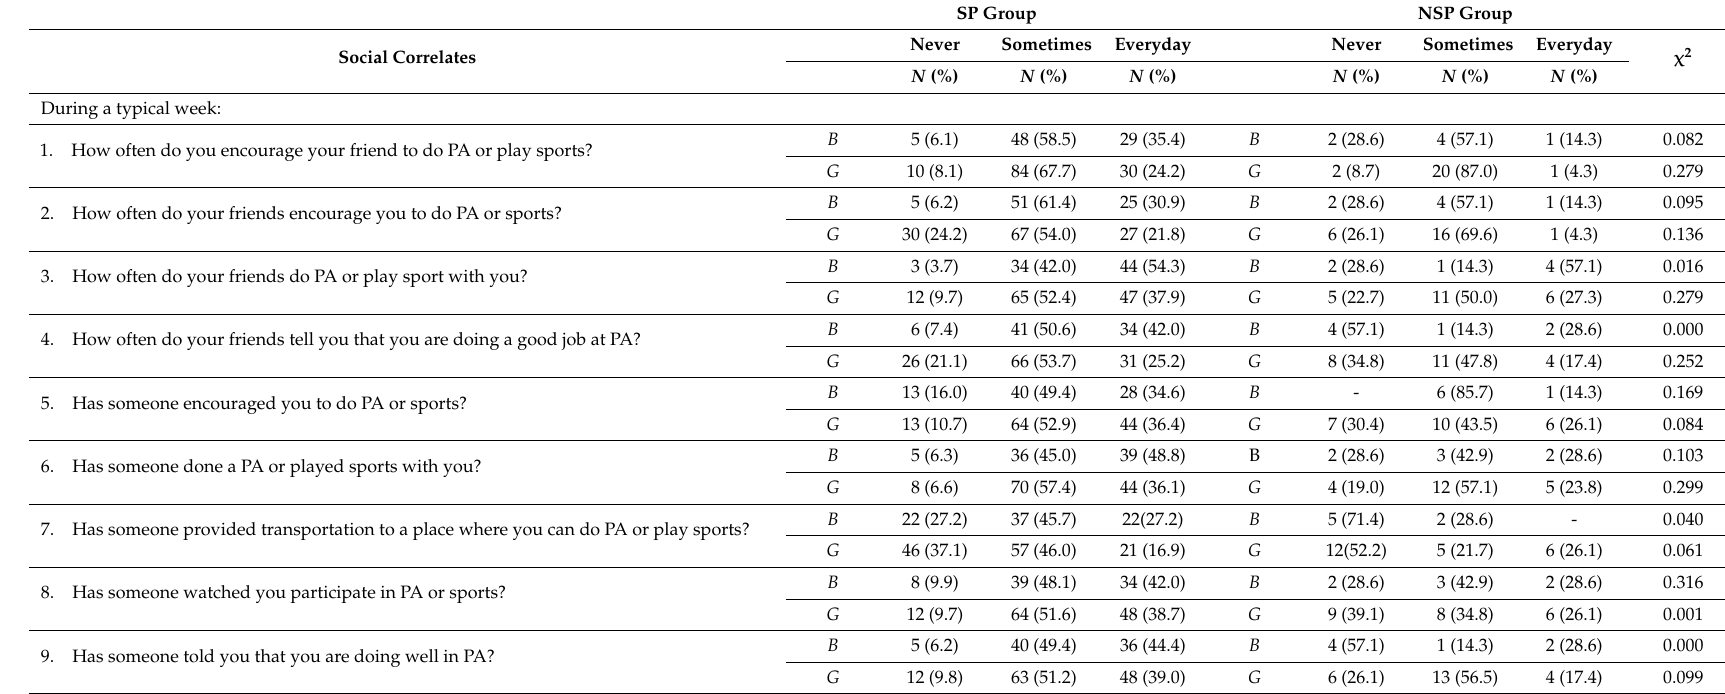
Table 5. Percentage (%) social correlates of physical activity by group and gender. SP Group NSP Group Social